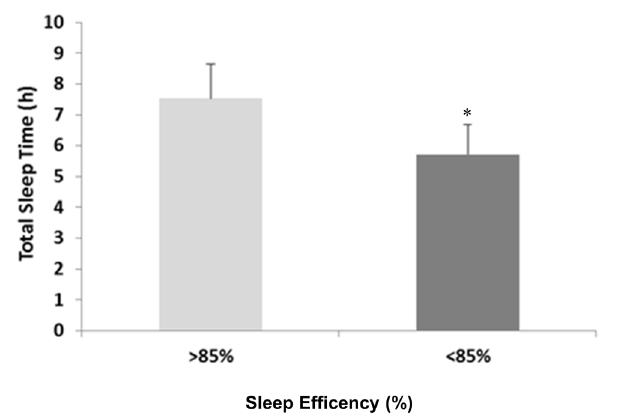
Figure 3. Association of total sleep time and sleep efficiency higher or lower than 85%, using the Pittsburgh Questionnaire. α ≤ 5% is defined as statistically